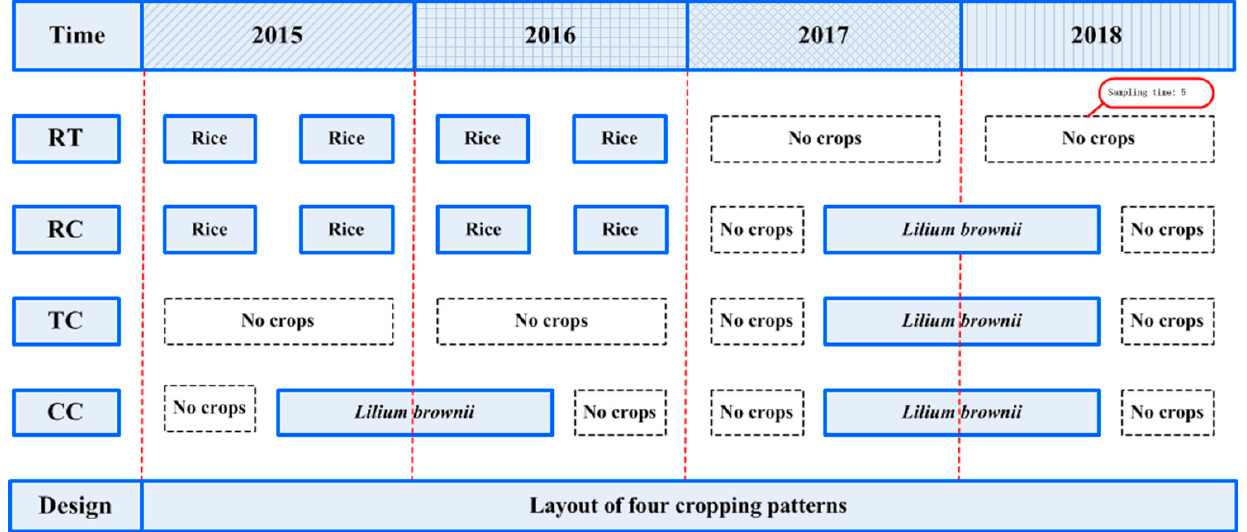
Figure 3. Timeframe for the field experiment and soil sampling RT: No O. sativa and L. brownii cultivation during the experimental period; RC: L. brownie - O. sativa - L. brownii rotation plots; TC: newly planted plots; CC: Two-year consecutively monocultured plots.